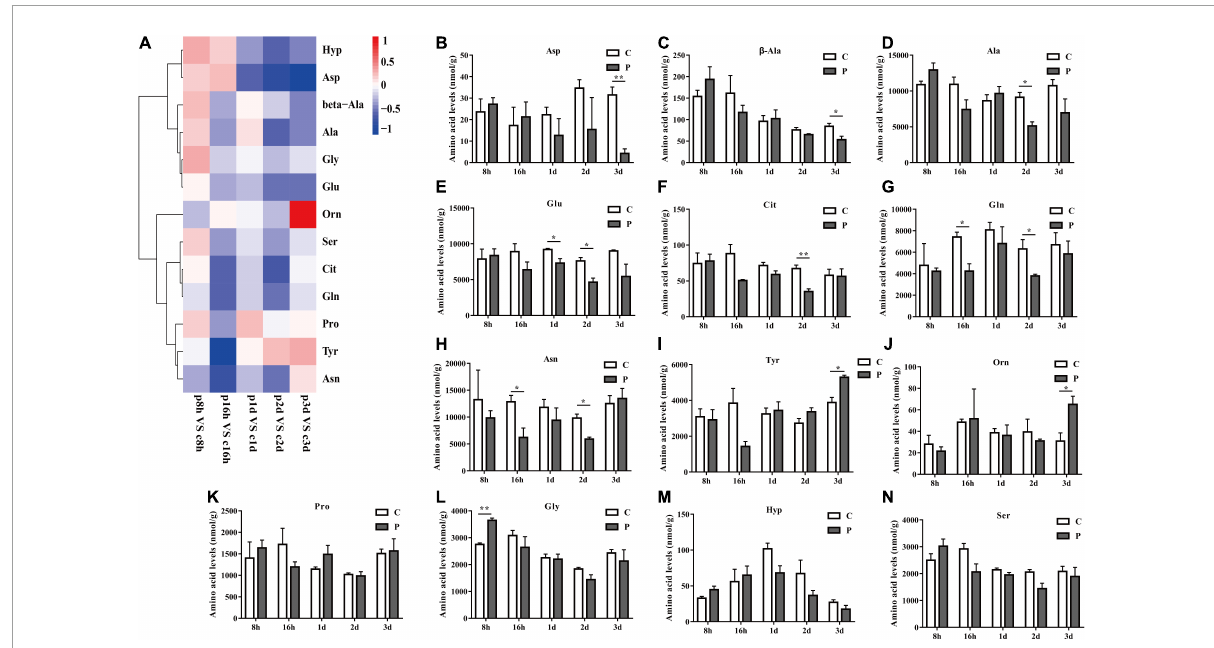
FIGURE5 Parasitism leads to changes in NEAA content of cotton aphid. Heatmap (A) and column (B–N) display of changes in NEAA. C, Non-parasitized cotton aphids; P, Parasitized cotton aphids. The log2(Fold change) of amino acid content change is represented by heat map color scale, red indicates up-regulation and blue indicates down-regulation. Statistical significance (Student’s t -test): * P < 0.05; ** P < 0.01; *** P < 0.001.